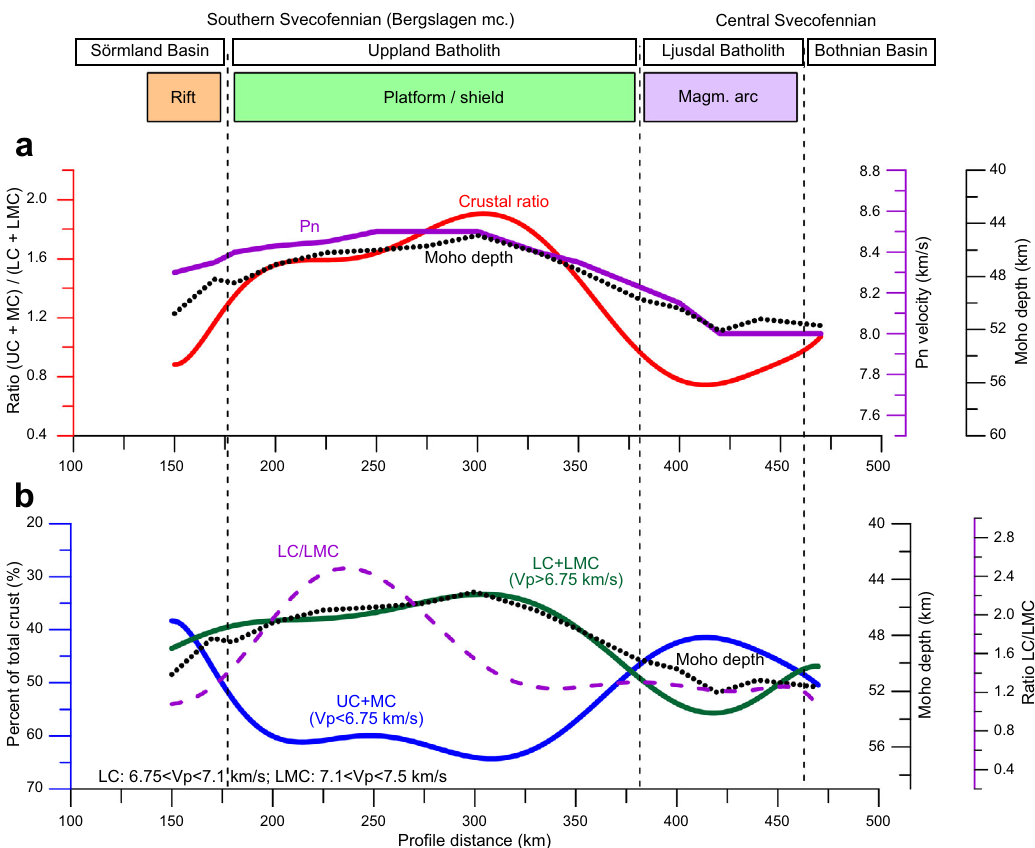
Fig. 8 Variations in the Moho depth, Pn velocity and thickness of the crustal layers along the pro fi le. a Ratio between thickness of the felsic- intermediate crustal layer (Vp < 6.75 km/s) to the ma fi c lower crustal layer (6.75 < Vp < 7.5 km/s) (red), together with Pn velocity (purple) and Moho- depth (stippled black); please notice the close coincidence. b Moho depth (black), relative thicknesses (in %) of the felsic-intermediate crustal layer (UC + MC, Vp < 6.75 km/s) (blue) and of the ma fi c lower crustal layer (LC + LMC, 6.75 < Vp < 7.5 km/s) (green) to total crustal thickness; also shown is the ratio LC/LMC of the thicknesses of the ‘ normal ’ lower crust (LC, 6.75 < Vp < 7.1 km/s) to the high-velocity lowermost crust (LMC, 7.1 < Vp < 7.5 km/s) (dashed purple line). The tectonic interpretation on the top is based on Fig.